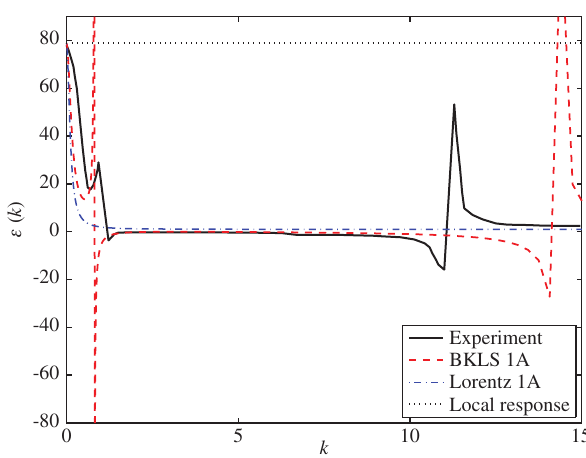
Figure 3 The dielectric function ε ( k ) estimated from experiment and from multiple models [147]. The data points associated with the experimental curve were obtained from Figure 2 of ref. [147] using the image processing software PlotDigitizer. The multi-mode BKLS model captures the experimental results qualitatively although not quantitatively, and the simple Lorentz model is accurate only in the k → 0 and k → ∞